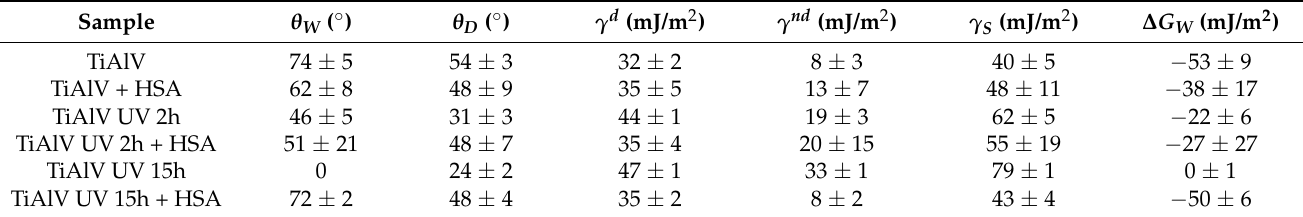
Table 2. Contact angles values for deionized water ( θ W ) and diiodomethane ( θ D ) obtained on the surfaces of TiAlV, TiAlV treated with UV-C light and TiAlV with adsorbed protein layer. Also shown in the table are the dispersive ( γ d ) and non-dispersive ( γ nd ) components of the surface tension, the total surface tension ( γ S ) of the solid, calculated using the Owens-Wendt-Kaelble (OWK) approach and the free energy of interaction between two surfaces ( ∆ G W ). Sample θ W ( ◦